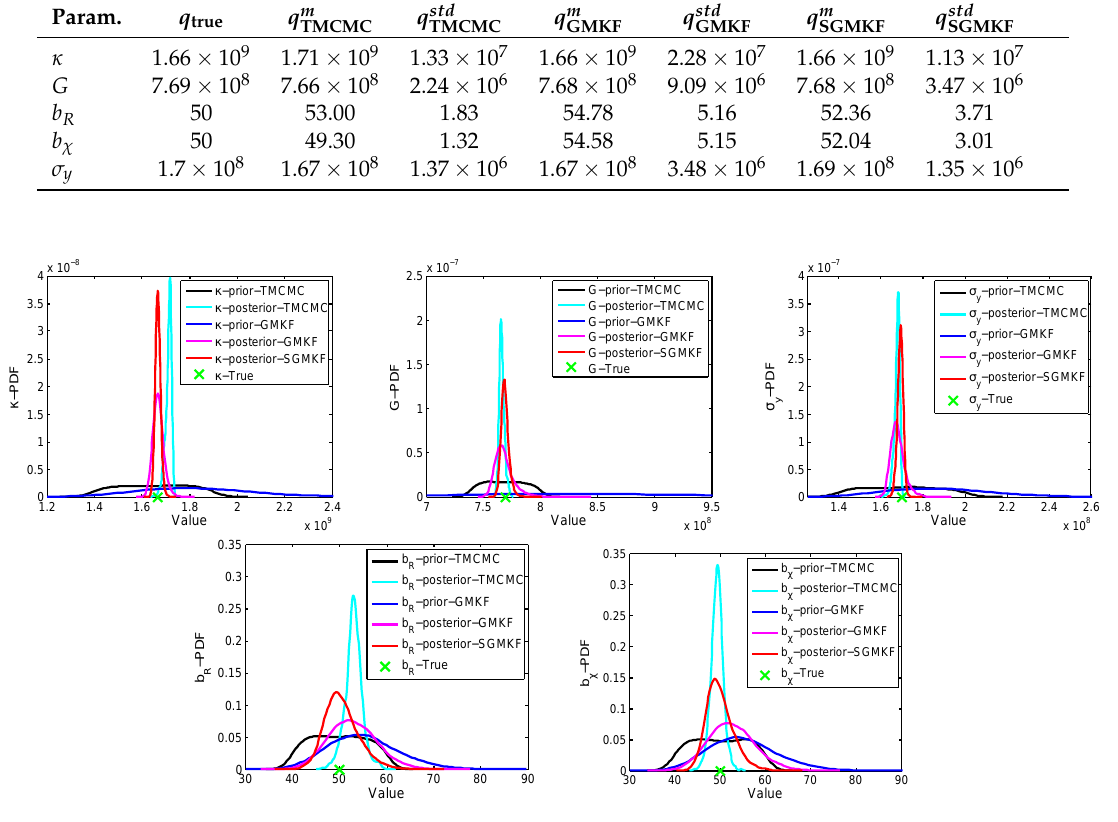
Figure 5. PDF of identified